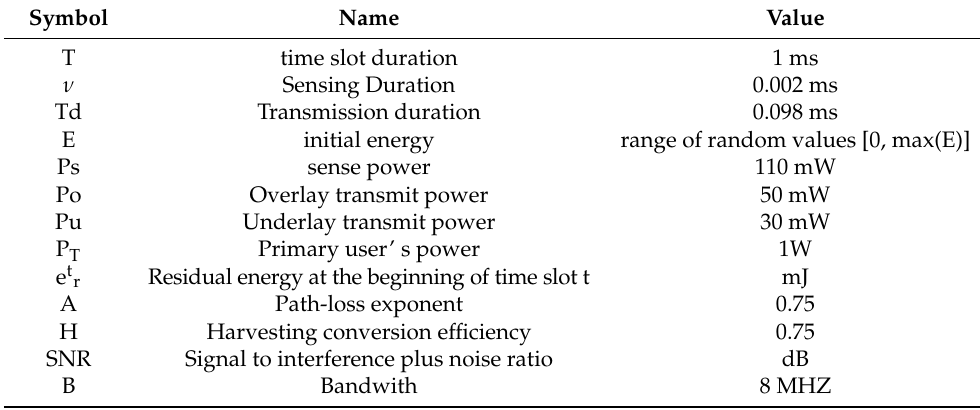
Table 1. Simulation